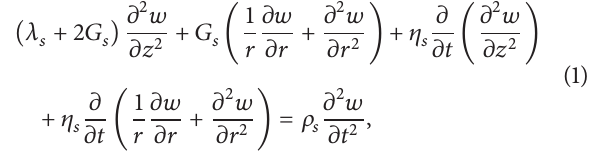
soil. Meanwhile, this model can take into consideration the layered characteristics and construction effect of pile end